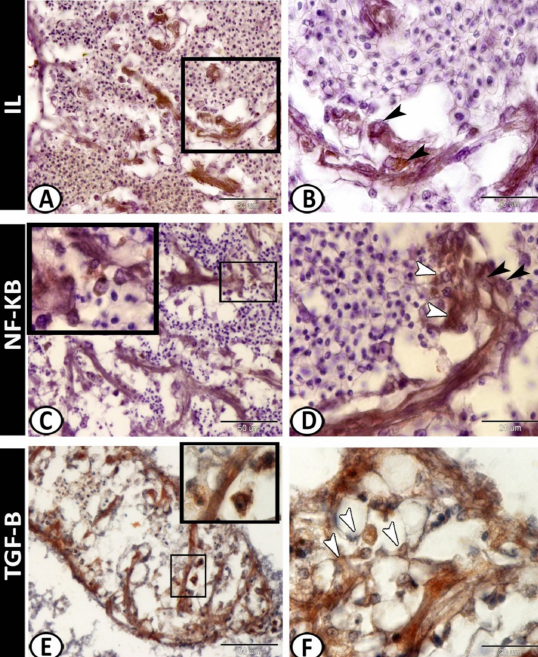
Figure 6. Immunohistochemistry of IL-1 β , NF- κ B, and TGF- β in the spleen. ( A , B ) IL-1 β showed immunoreactivity in monocytes and macrophages around the ellipsoids (arrowheads). ( C , D ) NF- κ B was expressed in the macrophages (boxed areas, white arrowheads) and epithelial reticular cells (black arrowheads). ( E , F ) TGF- β was expressed in the macrophages (boxed areas) and reticular cells (arrowheads).